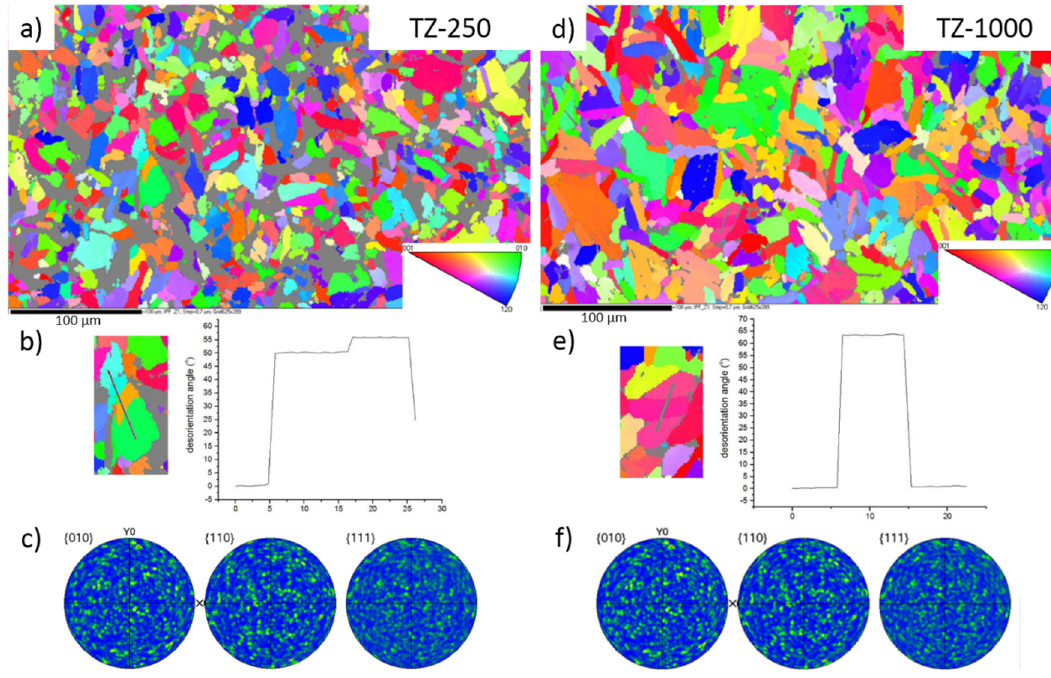
Figure 4. High-resolution electron backscatter diffraction pattern for the samples TZ-250 ( a ) and TZ-1000 ( d ) with representation of disorientation angle between grains for sample TZ-250 ( b ) and TZ-1000 ( e ). Pole figures for the sample TZ-250 ( c ) and TZ-1000 ( f ).